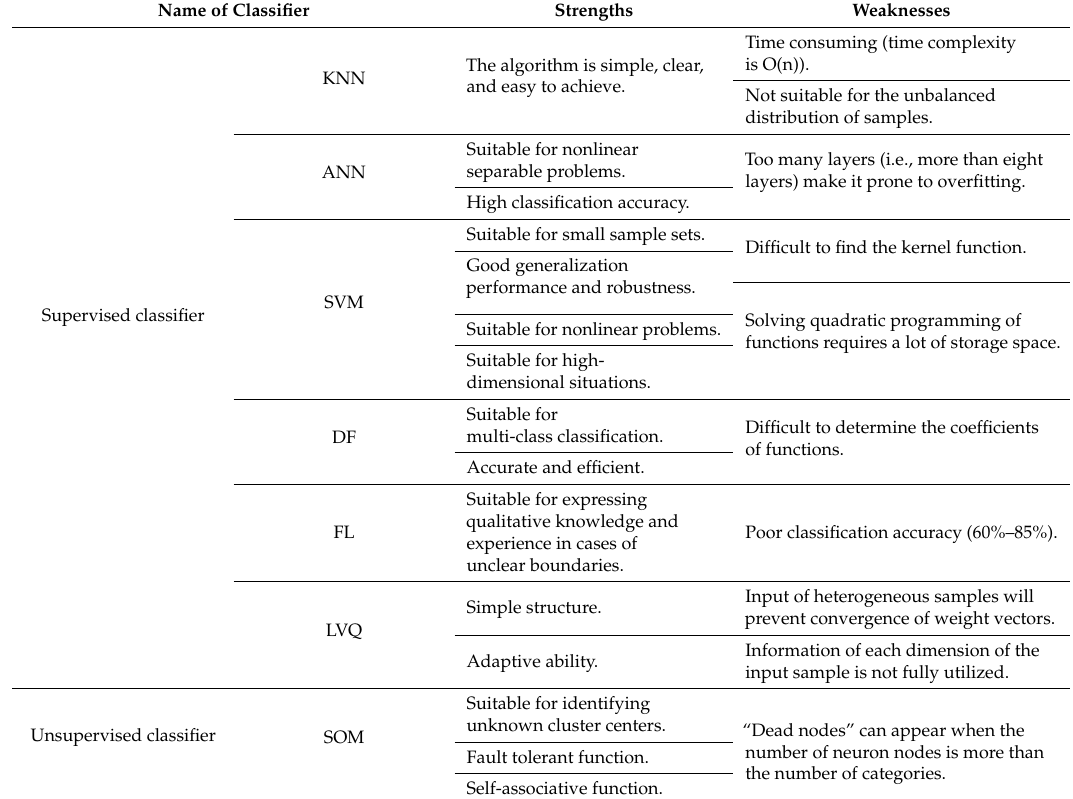
Table 7. Strengths and weaknesses of classifiers for steel defect